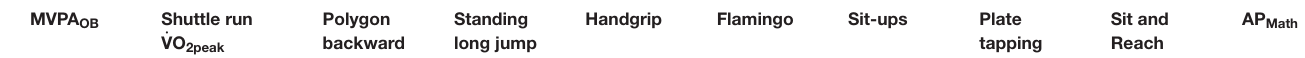
TABLE 2A | Correlation coefficients for dependent measures determined for boys and girls in Grade 6.